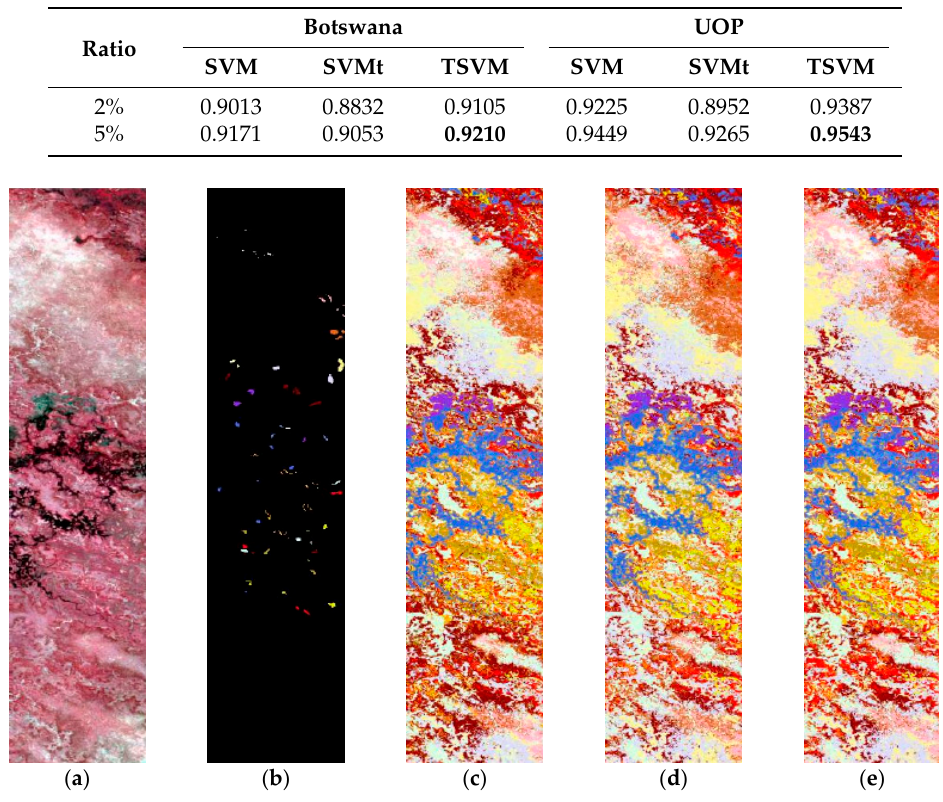
Table 4. The accuracy of three methods.